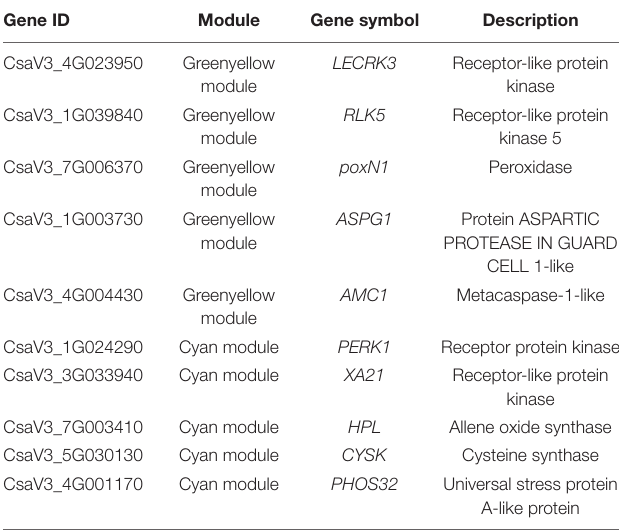
TABLE 1 | Hub genes selected from the co-expression